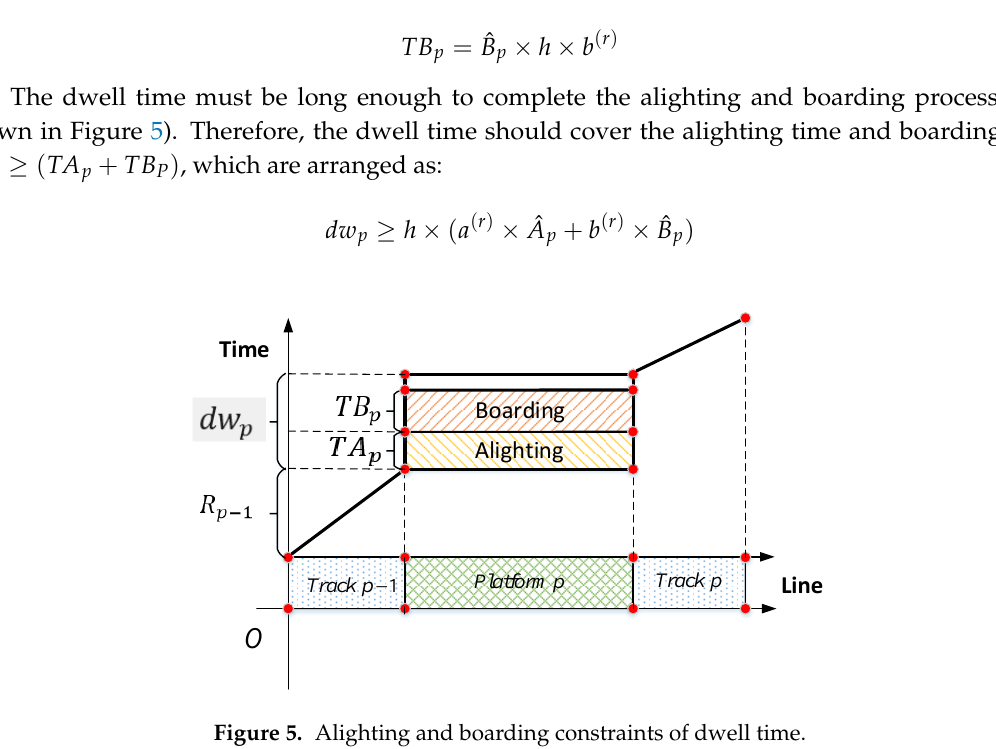
Figure 5. Alighting and boarding constraints of dwell